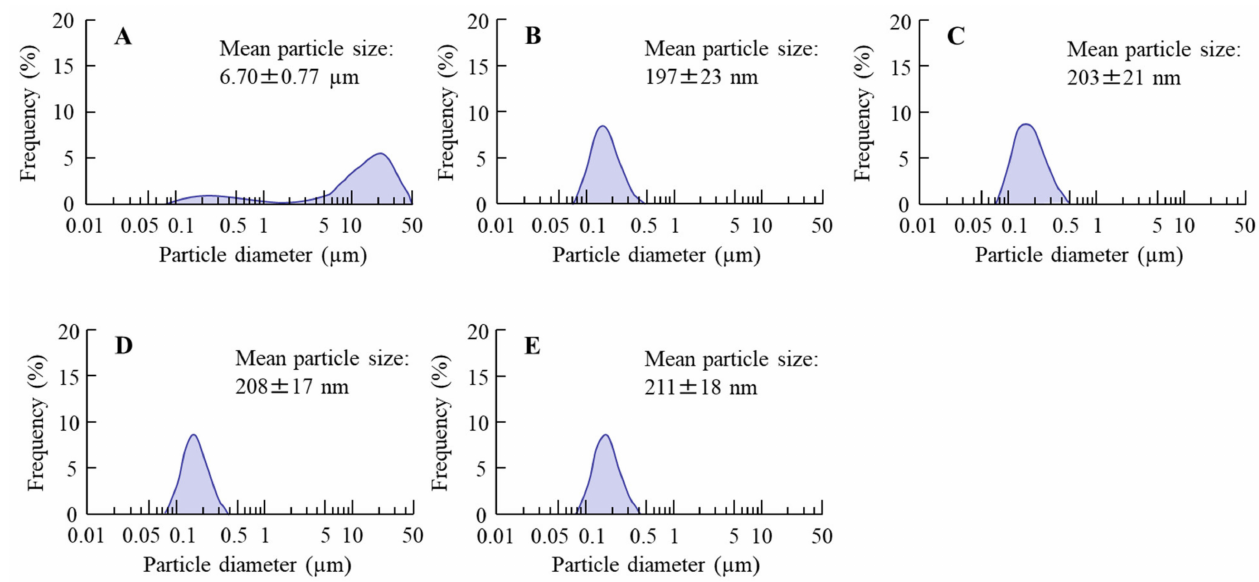
Figure 1. Particle size frequencies of PZI in CA-INS ( A ), nPZI ( B ), nPZI/PL ( C ), nPZI/PM ( D ), and nPZI/PH ( E ). The compositions of the INS ophthalmic formulations are shown in Table 1. The particle size of PZI was decreased by the bead mill, and the particle size frequencies in nPZI and nPZI/P were approximately 80–550 nm.